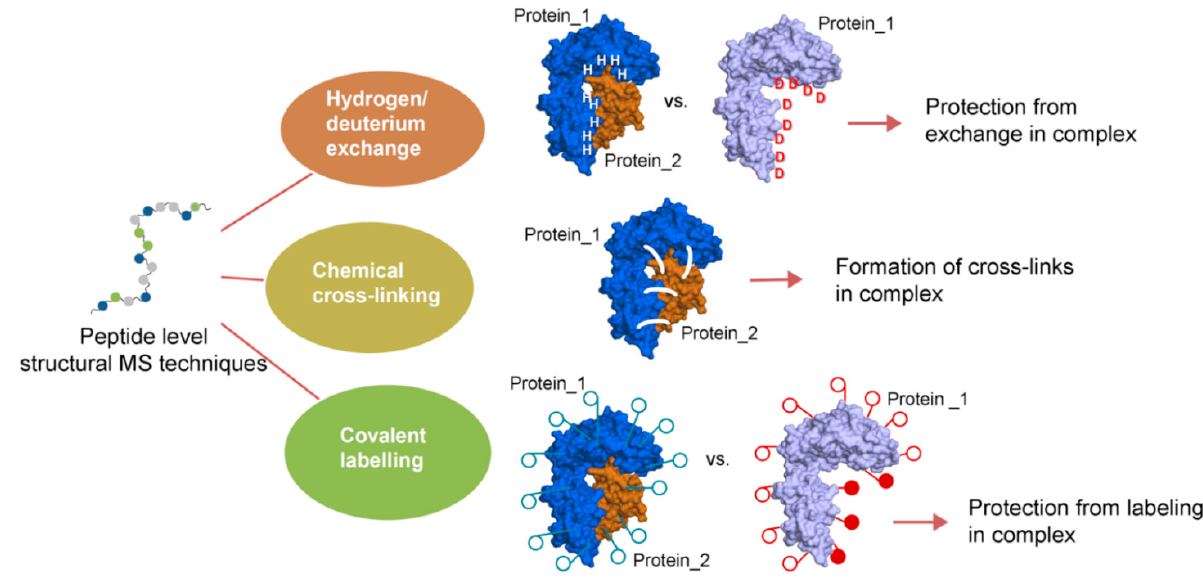
Figure 3. Three important mass spectrometry approaches used in the structural proteomics analysis of binary complexes. In the hydrogen/deuterium exchange, H 2 O is replaced by D 2 O and the resulting exchange associated with a mass increase can be detected by mass spectrometry (MS). Chemical cross-linking, comprises the covalent coupling of two reactive groups within a protein or between two different proteins, and then by introducing cross-links at the specific residues, spatial information at different levels can be obtained using MS. In covalent labeling, irreversible modifications are introduced at the reactive side chains and the solvent or surface exposed residues in proteins can be identified [23,72]. In this figure the protein or peptide structures were prepared using the BIOVIA Discovery Studio (Dassault Systèmes, BIOVIA Corp., San Diego, CA, USA) visualizer.